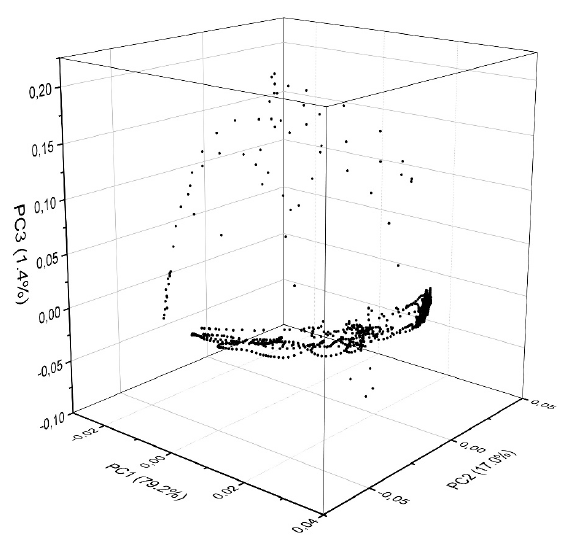
Figure 5: 3-dimensional score plot of PCA.